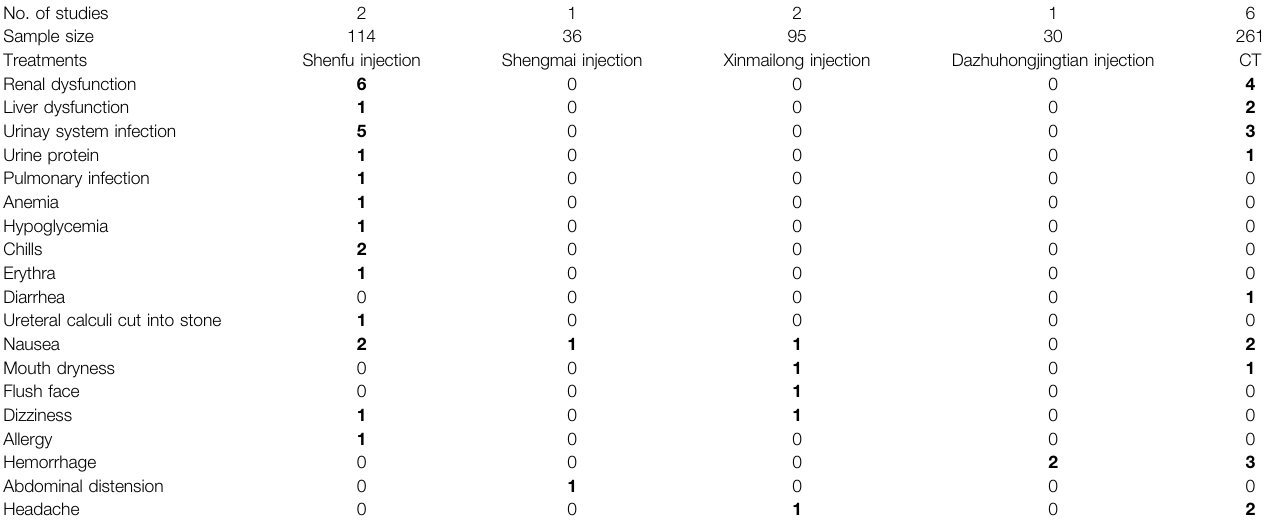
TABLE 2 | Occurrence of adverse reactions of